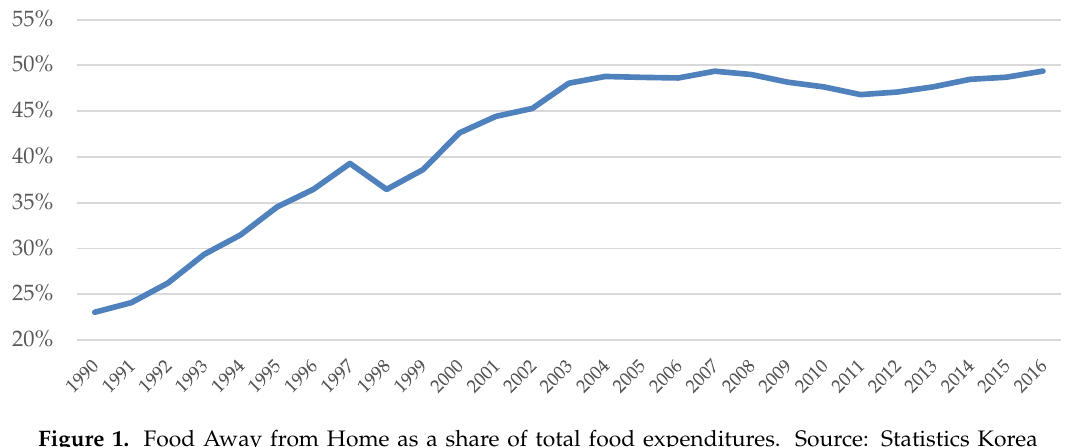
Table 1. Description of multivalued hypothetical treatment